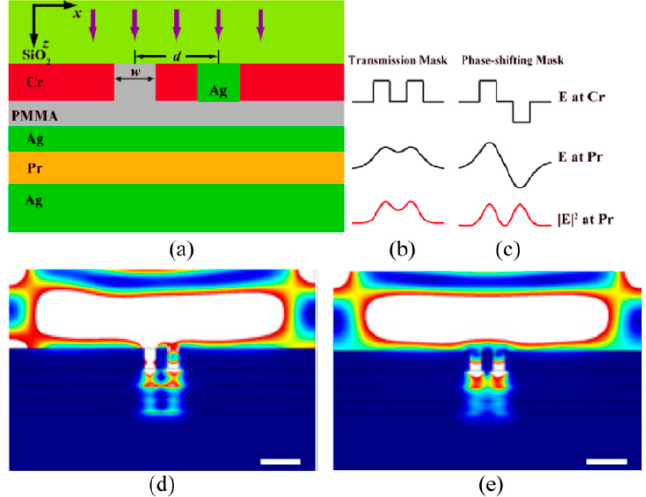
Figure 30. ( a ) Schematic structure of plasmonic lithography incorporating PSM; ( b , c ) Principle of plasmonic PSM; Simulation results of 30 nm resolution pattern ( d ) with PSM and ( e ) without PSM. Reproduced from [113], Copyright © 2011, OSA.